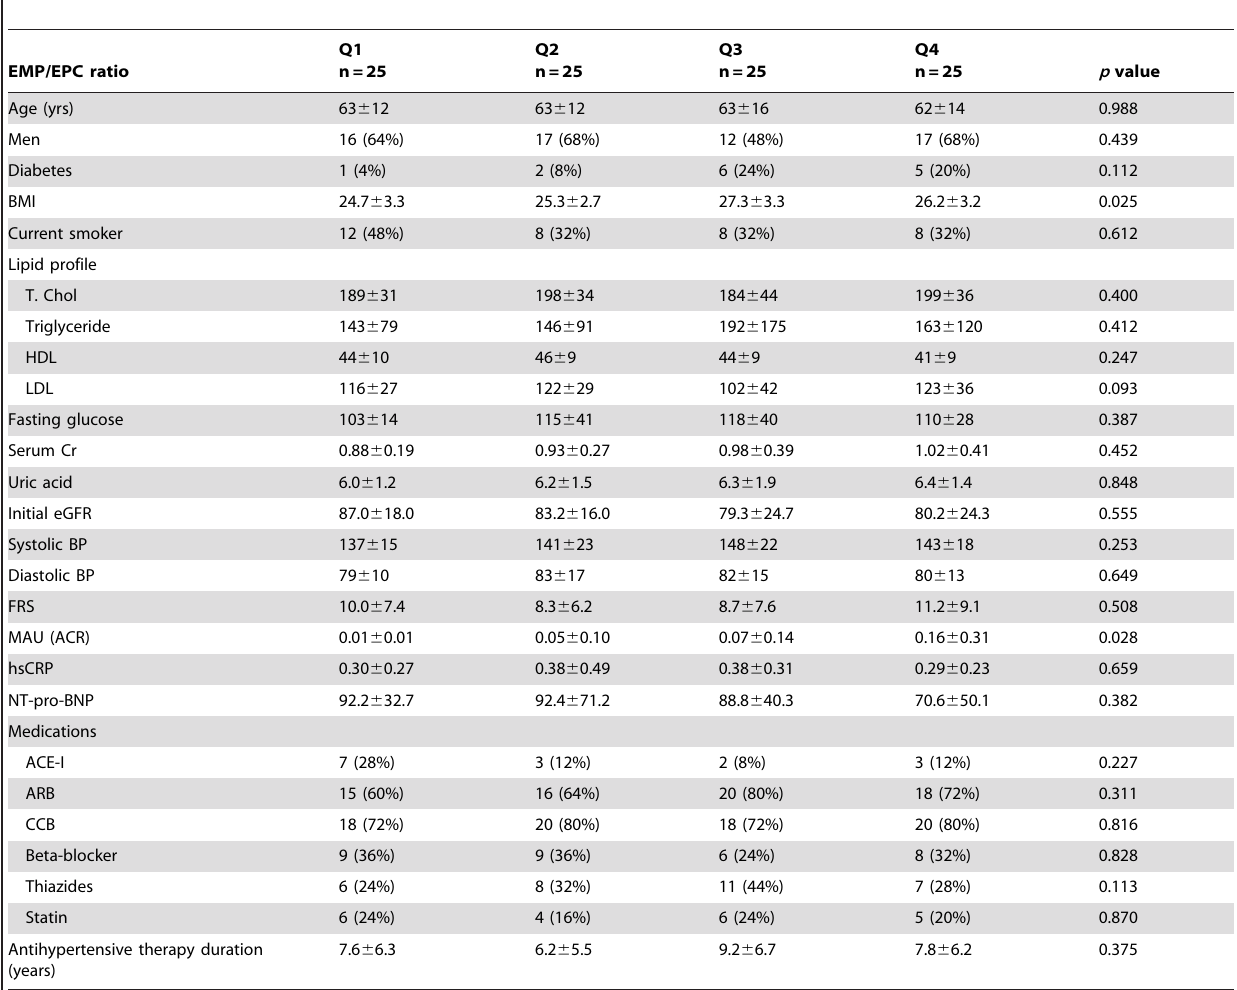
Table 2. Baseline characteristics in 4 groups of hypertensive patients according to EMP/EPC